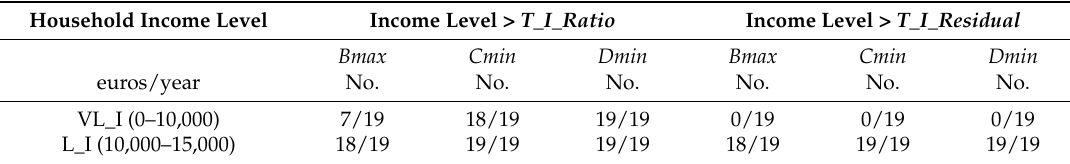
Figure 9. T_I_ratio ( a ) and T_I_residual ( b ) in euros/year ( y -axis) per zone and per municipality in the SES area. Table 7. Frequency of housing affordability per income level and per zone in the SES